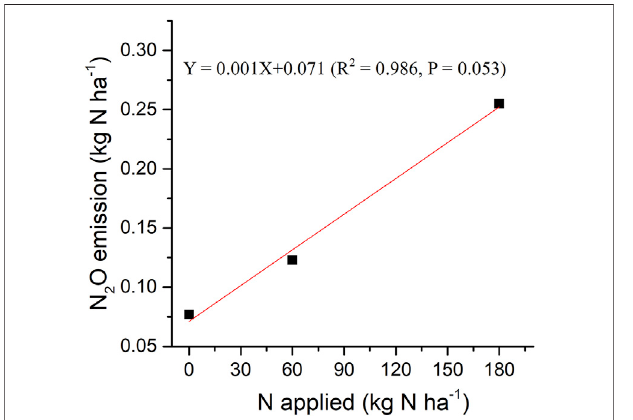
FIGURE 4 | Relationship between the cumulative N 2 O emission between the sowing and jointing stages and the N applied.